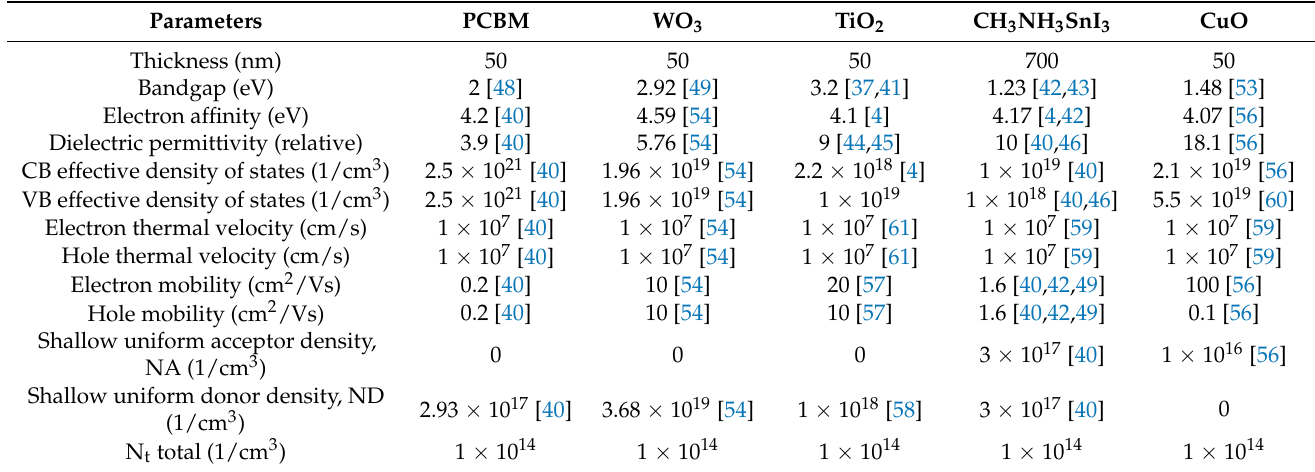
Table 1. Simulation parameters for perovskite solar cell using